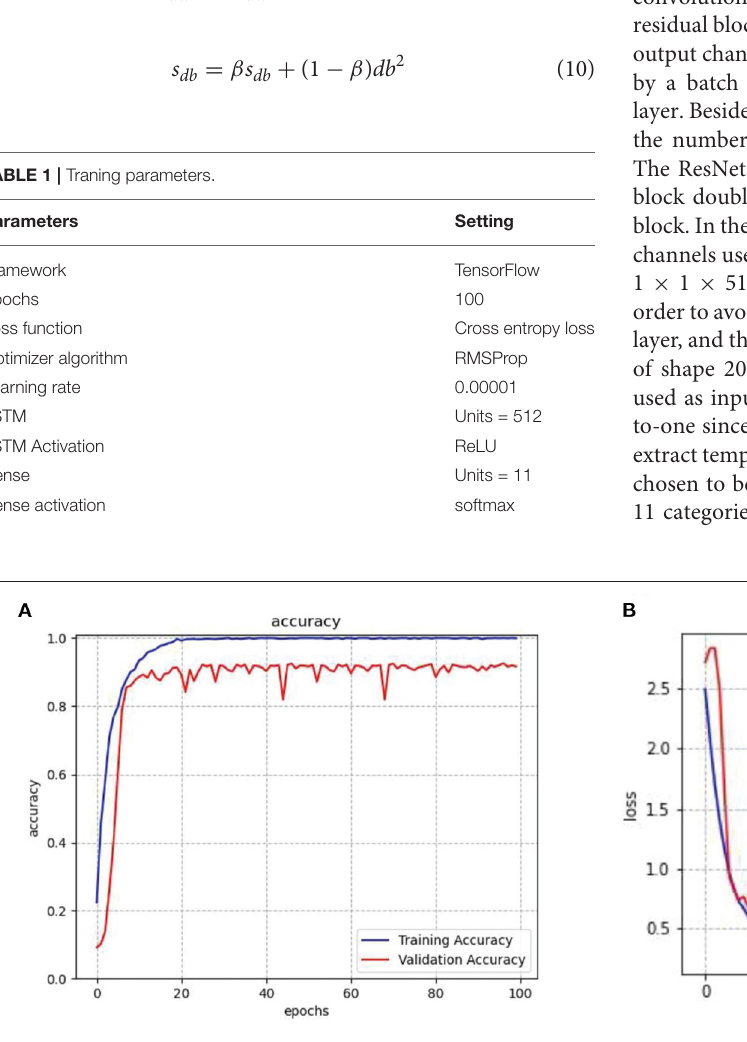
FIGURE 6 | (A) Accuracy change in ResNet-18 and LSTM model. (B) Loss change in ResNet-18 and LSTM model.